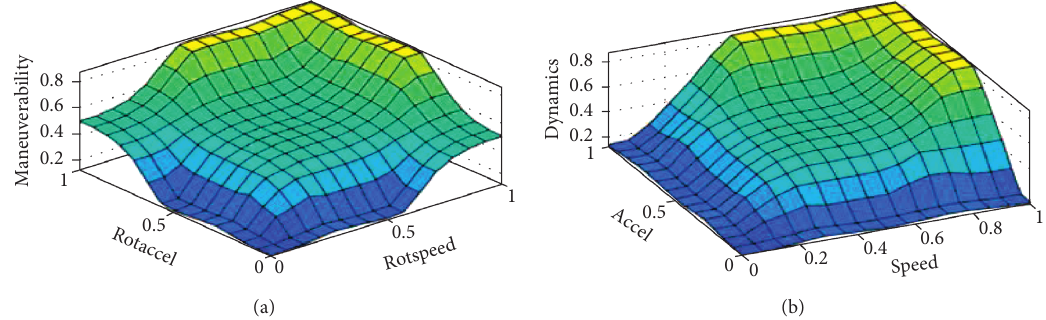
Figure 20: (a) Fuzzy output surfaces for model N 1 and (b) fuzzy output surfaces for model N 2.